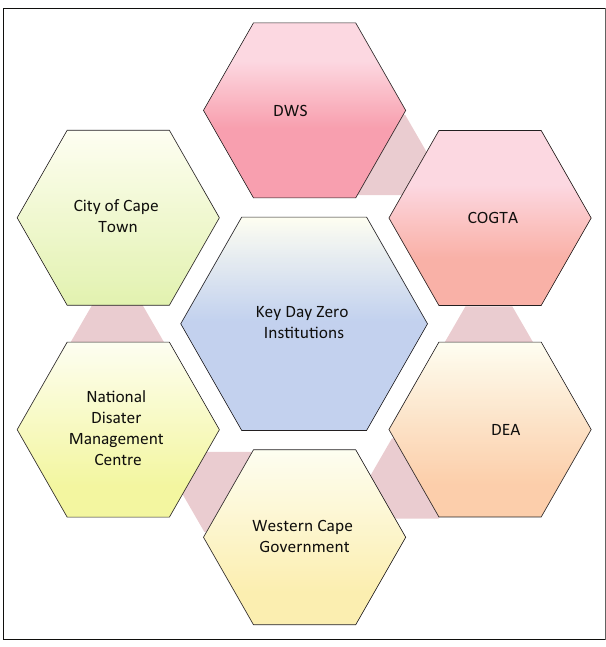
FIGURE 4: Key state institutions involved in Day